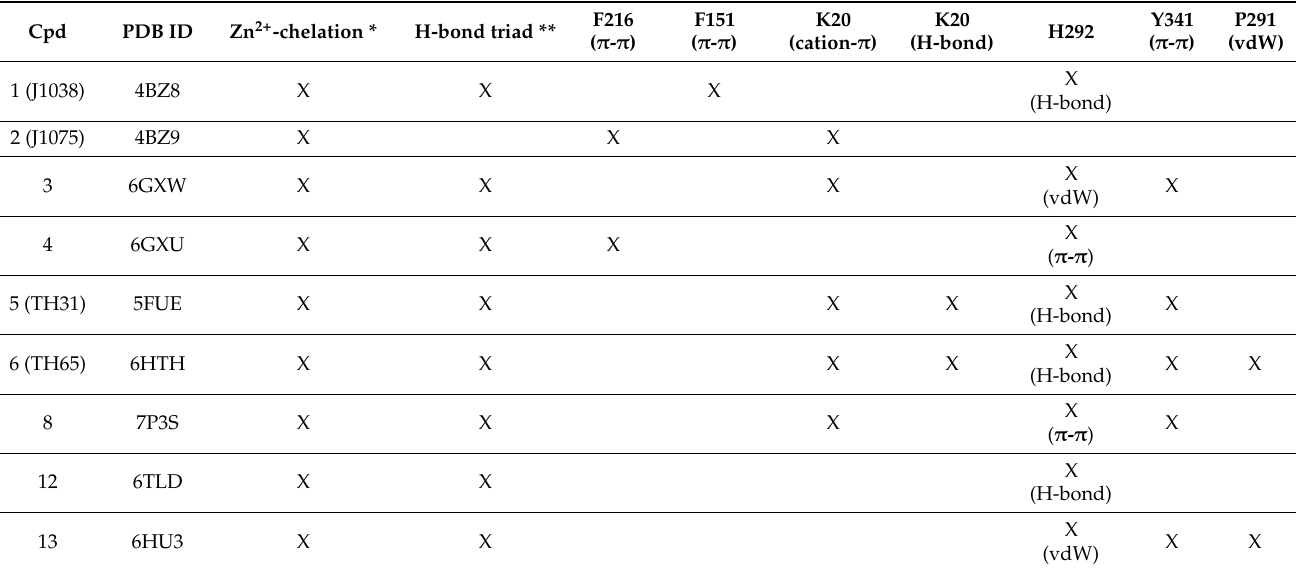
Table 1. Observed interactions of the herein mentioned inhibitors in the binding site of smHDAC8 (vdW = van-der-Waals